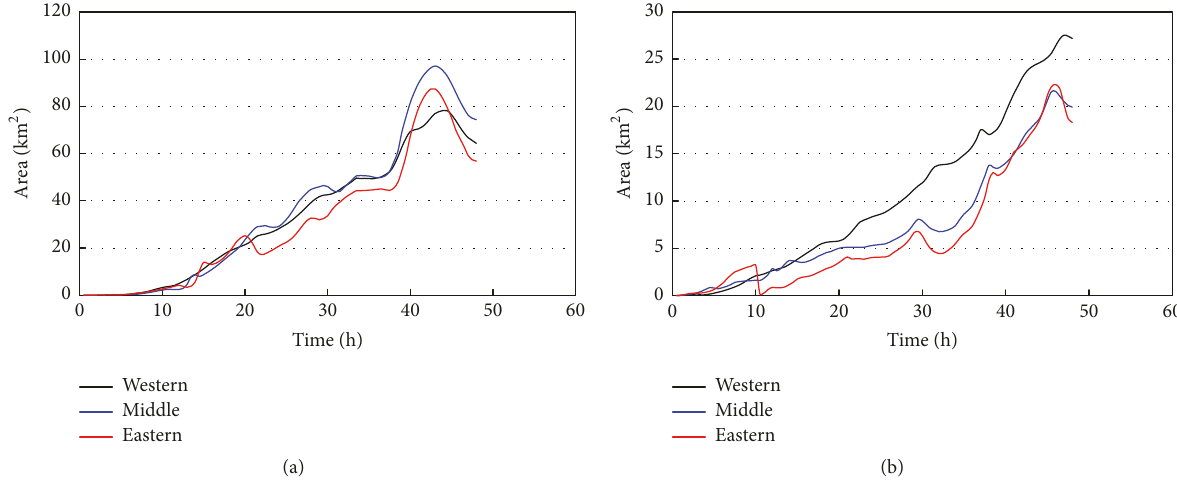
Figure 20: Area of instantaneous (a) and continuous (b) oil spills versus time in different spill locations (black line for the western spill location, blue line for the middle spill location, and red line for the eastern spill location) in the case of no